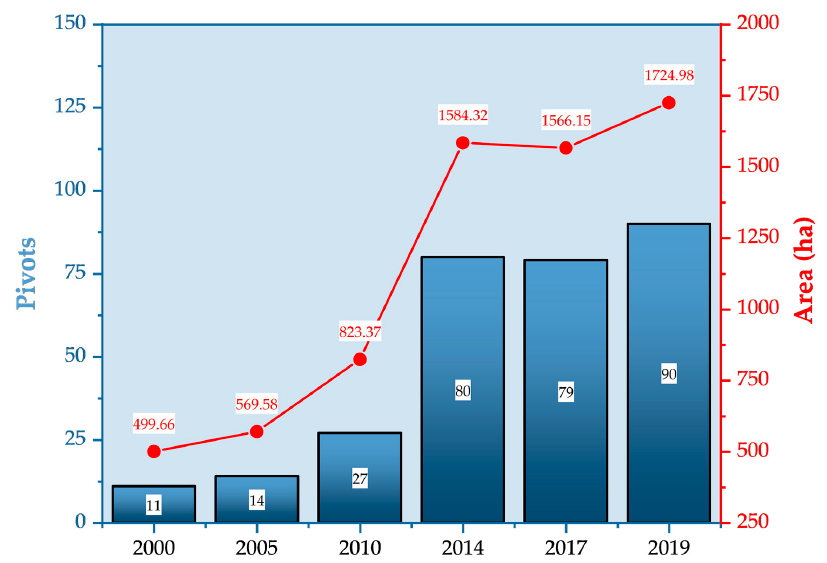
Figure 13. Estimation of area and number of center pivots in the study area in the period from 2000 to 2019. to